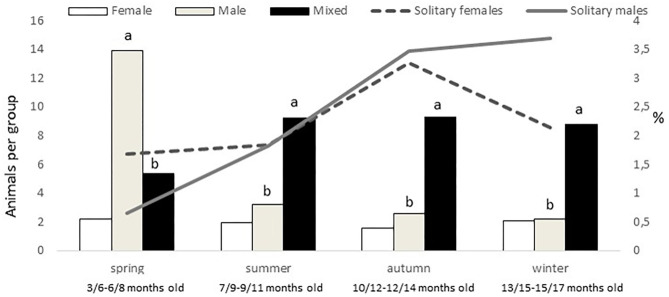
In the left axis and with bars, mean number of animals per group (female, male, and mixed groups). In the right axis and with lines, percentage of solitary females and males out of the total females and males observed for the different seasons (spring: March to May; summer: June to August; autumn: September to November and winter: December to February) in free-range Iberian pigs, being the youngest in spring and the oldest in winter.